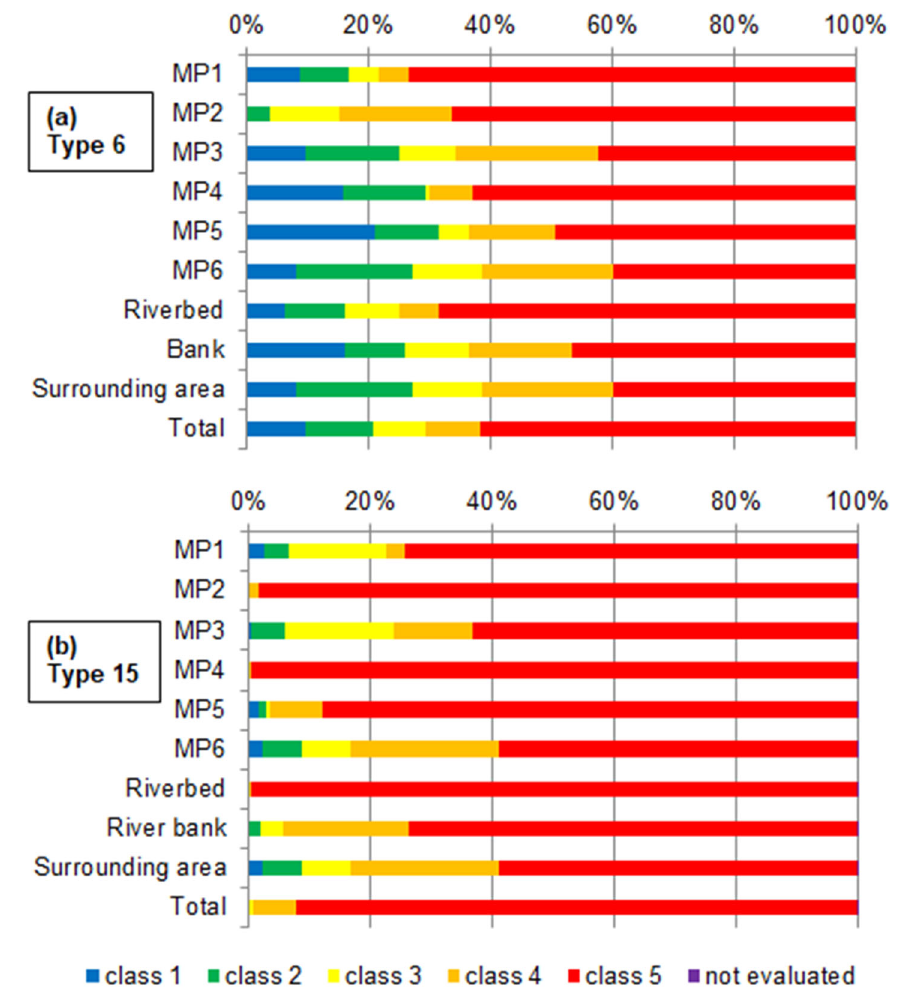
Figure 3. Structure classes 1 to 5 of the evaluation of the river type 6 ( a ) and river type 15 and 15_g ( b ) sections of the Hase River (uplands) of the main parameters MP1 to MP5 and riverbed, river bank, land and total evaluation.